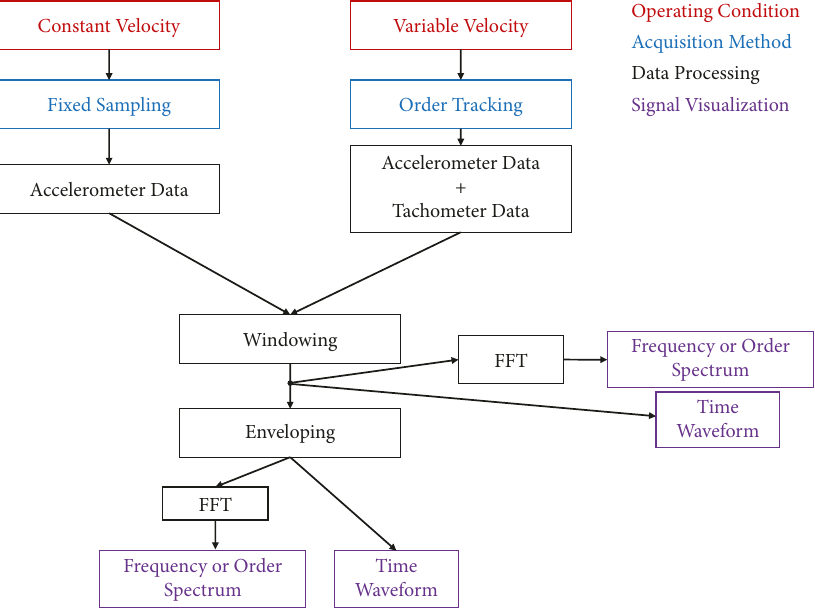
Figure 12: Signal processing steps.